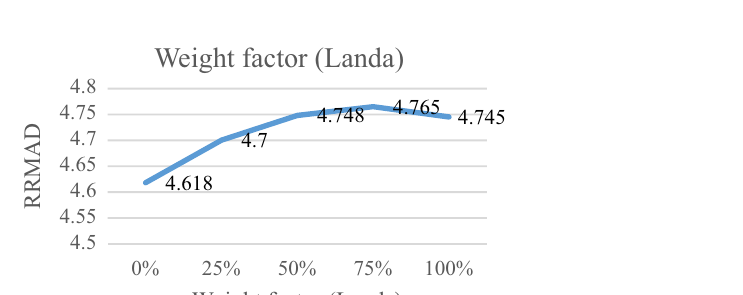
Figure 10. Analyzing the confidence level.